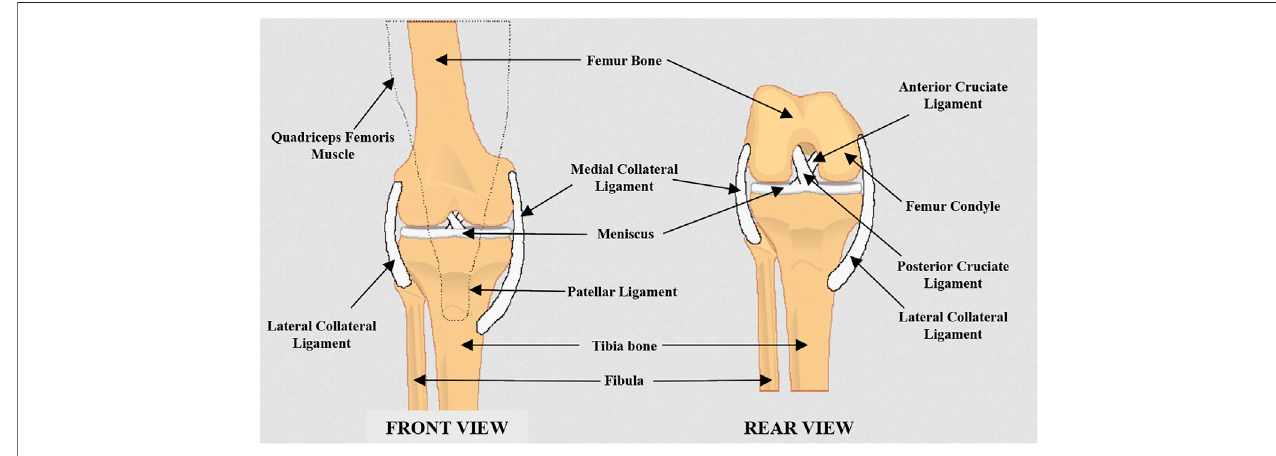
FIGURE 1 | Anatomy of human knee joint (front view and rear view).